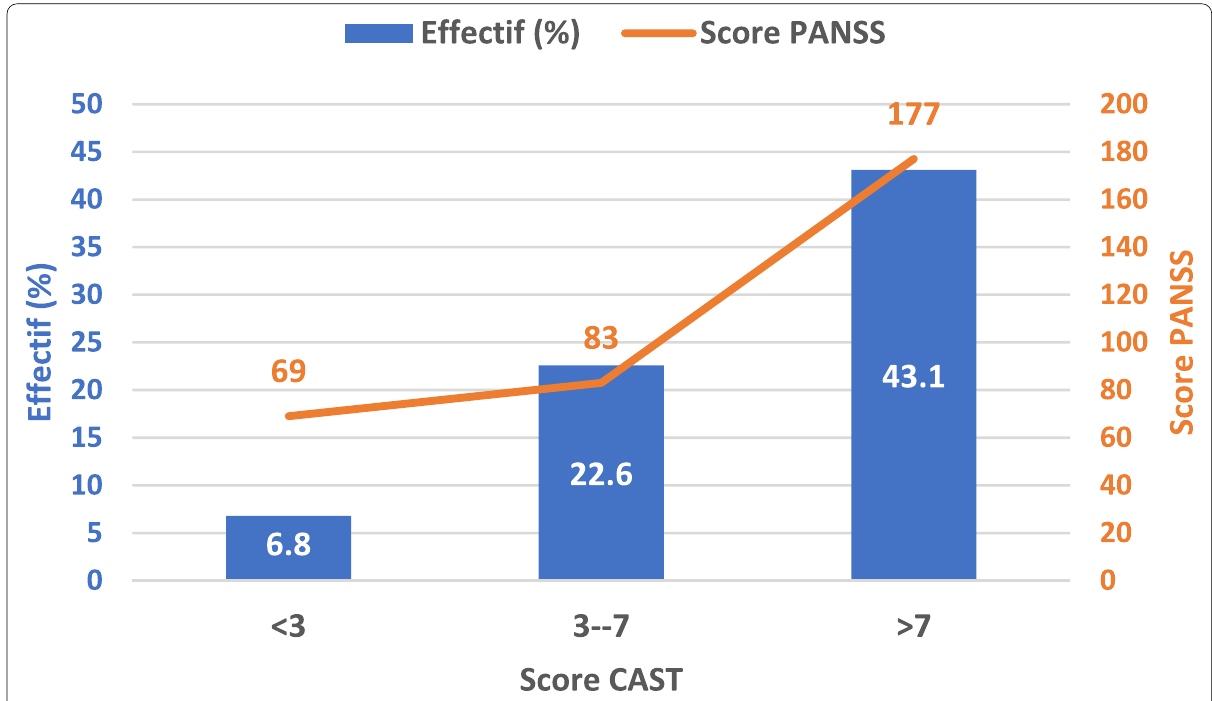
Fig. 1 Dose-effect relationship between frequency of cannabis use and PANSS Total score